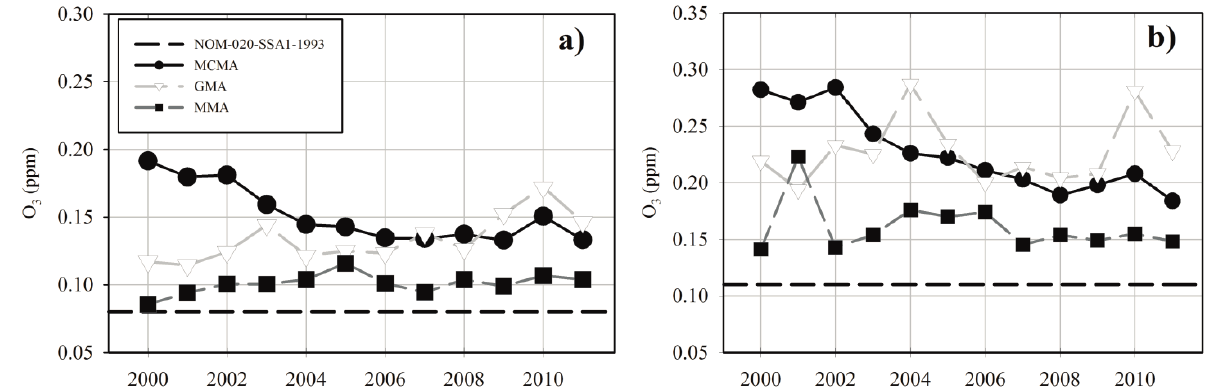
Figure 11. ( a ) Annual fifth maximum values of 8-h moving averages and ( b ) maximum values of 1-h averages of O concentrations in the three Mexican metropolitan areas. The 3 dashed lines indicate the MPL in